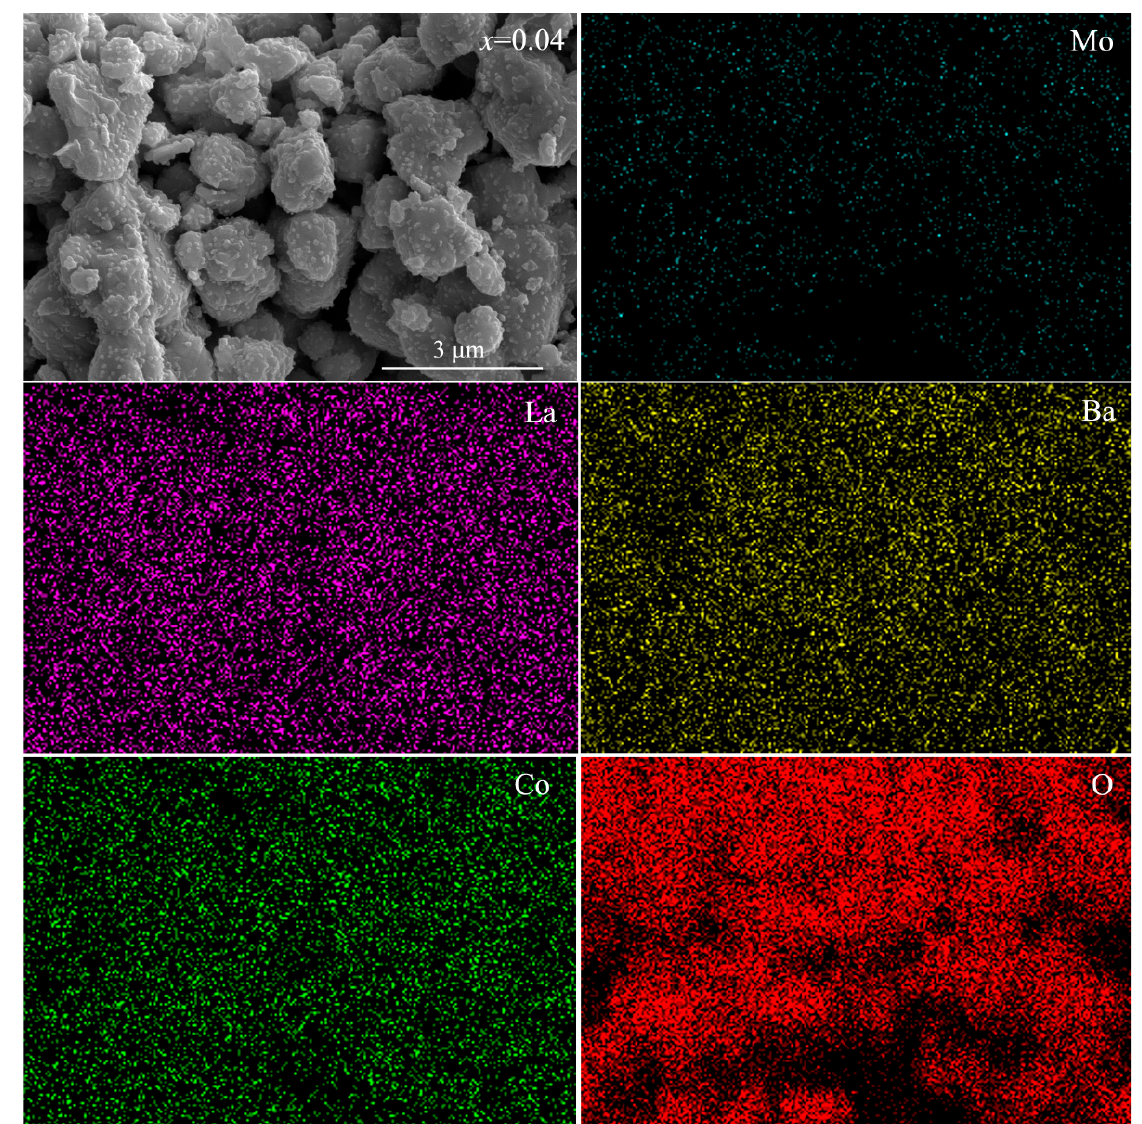
Figure 3. Elements mapping of LBCM0.04.